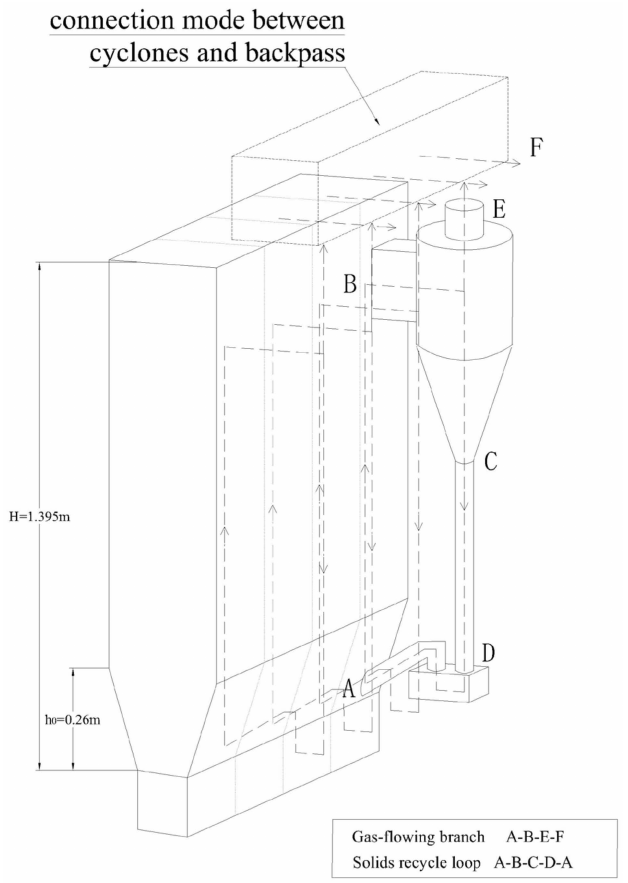
Figure 5. Diagram of gas-flowing branch and solids recycle